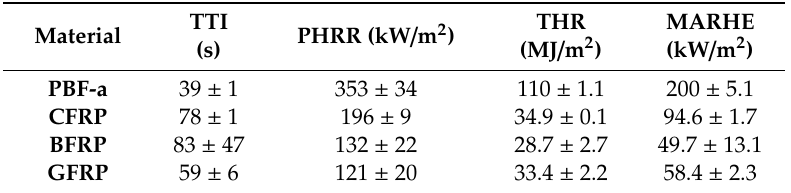
Table A6. Cone calorimeter test results of neat PBF-a as well as carbon, glass and basalt fiber reinforced PBF-a.